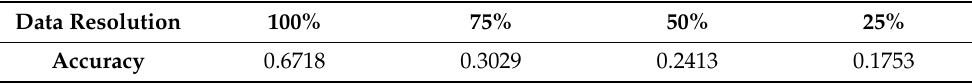
Table 3. Accuracy of classification on down sampled Sydney Urban Data